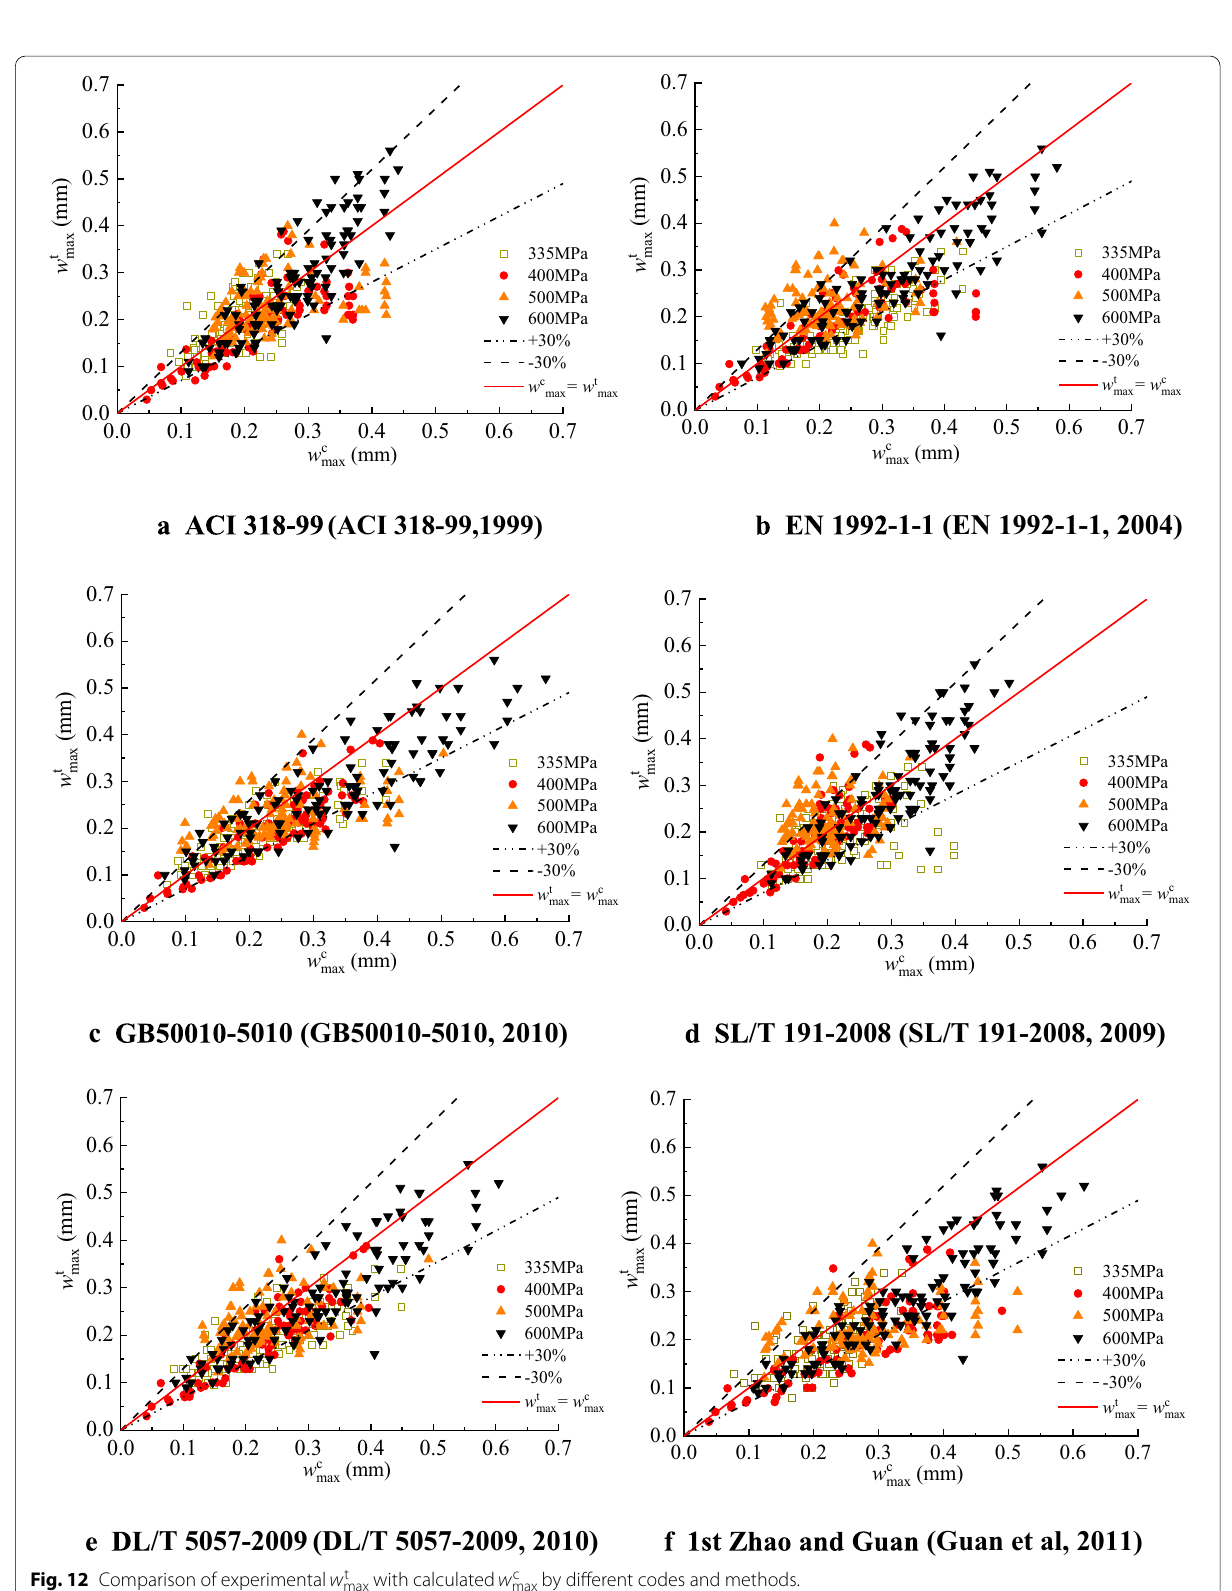
Fig. 12 Comparison of experimental w t max with calculated w c max by different codes and